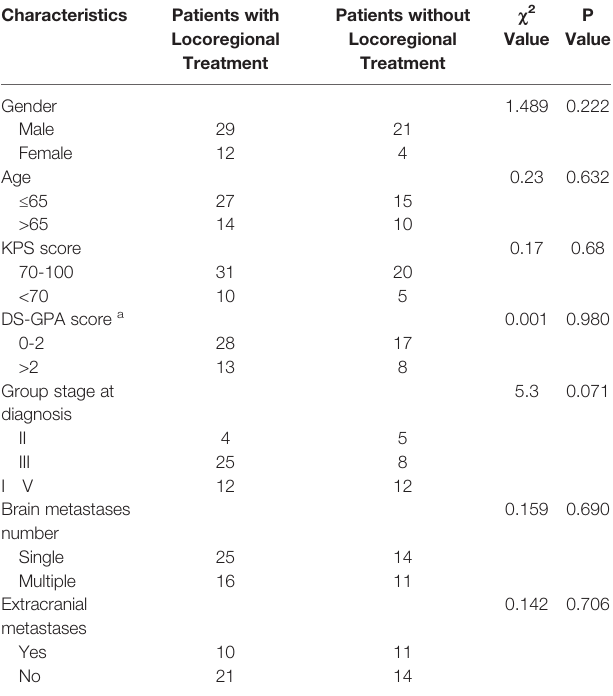
TABLE 1 | Characteristics of patients with or without locoregional treatment. Characteristics